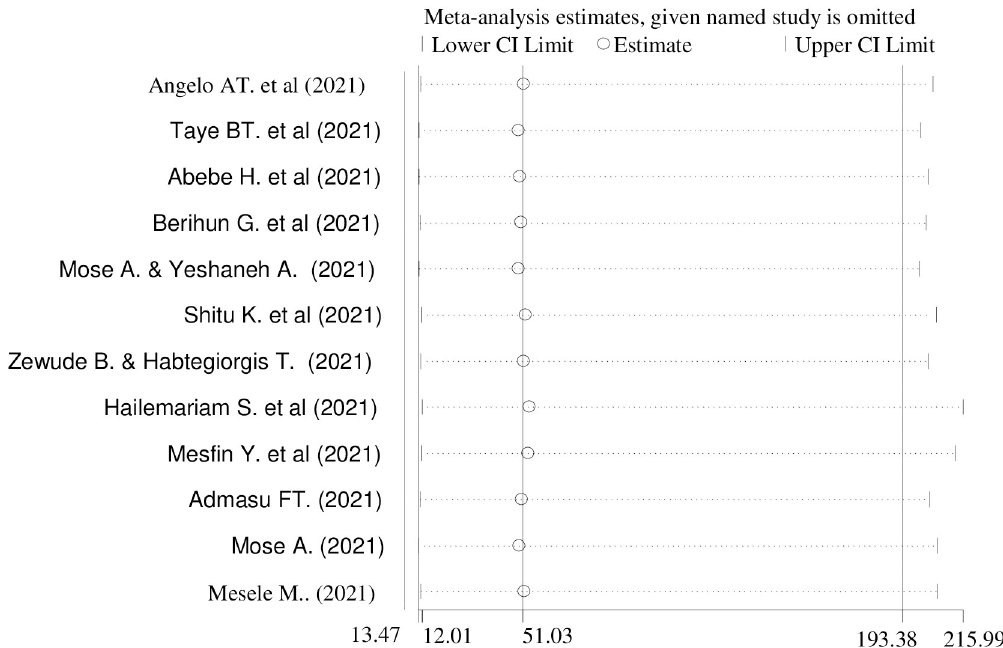
Fig 6. Sensitivity analysis of the prevalence of COVID-19 vaccine acceptance and its determinant factors in Ethiopia, 2021.